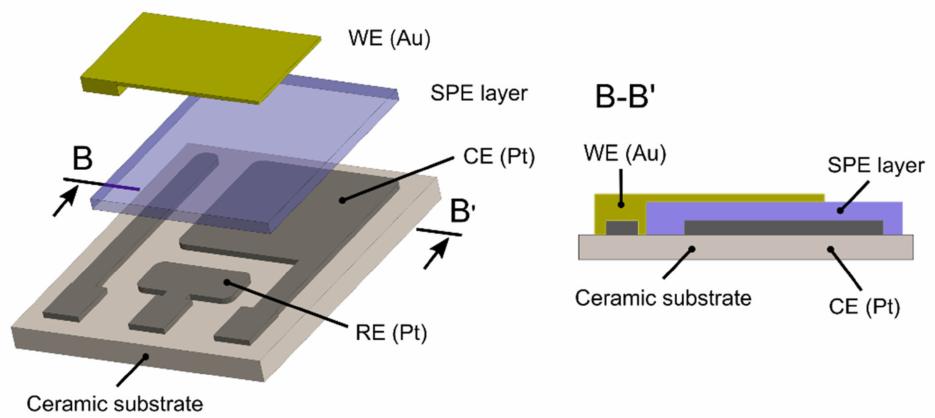
Figure 2. Semi-planar topology of the new ethylene